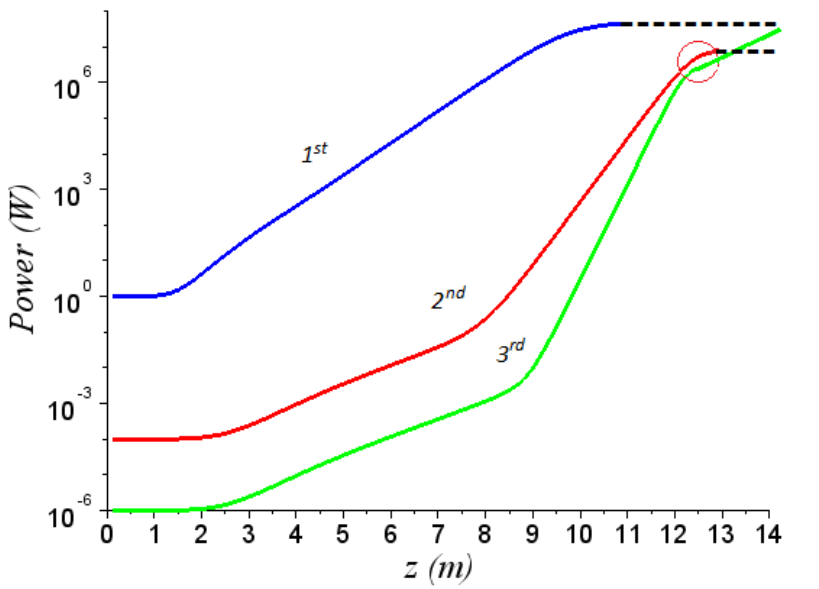
Figure 6. Evolution of the first, second and third harmonics. The third harmonic is further amplified by the second beam at higher energy and brought at the same level of the